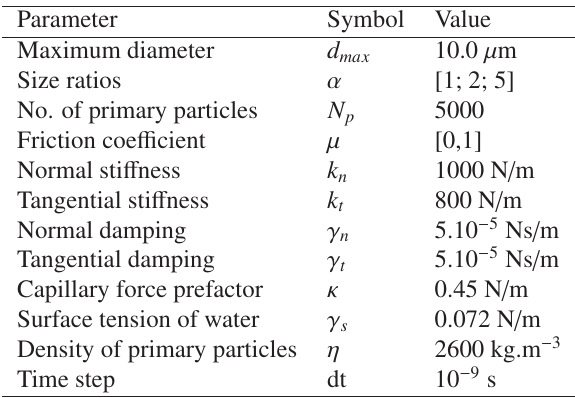
Table 1. Parameters used in these